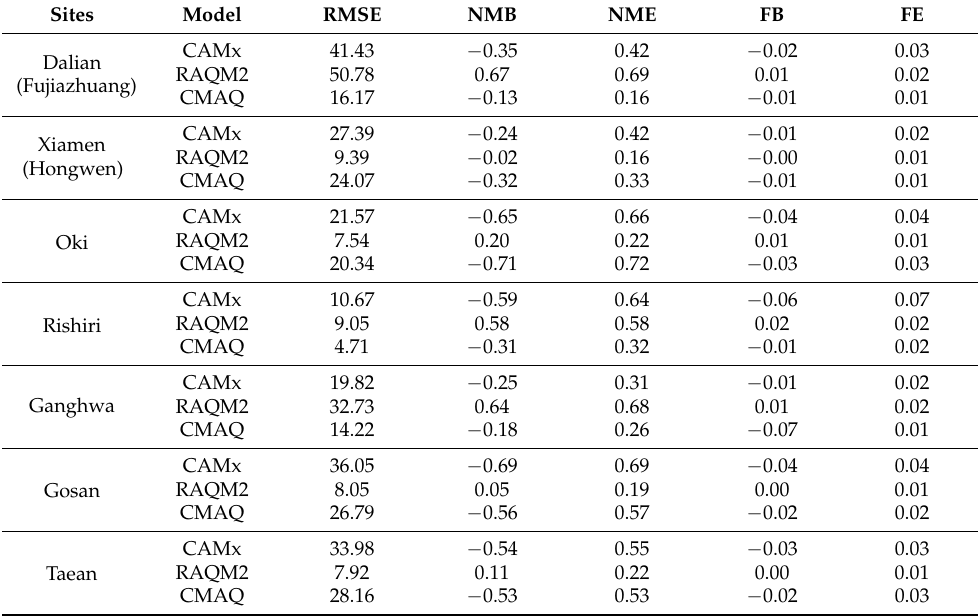
Table 2. Statistical summary of simulated and observed PM 10 levels over six exit-and-entrance sites related to transboundary transport over China, Japan, and Korea. Here, RMSE, NMB, NME, FB, and FE denote root mean square error, normalized mean bias, normalized mean error, fractional bias, and fractional error,